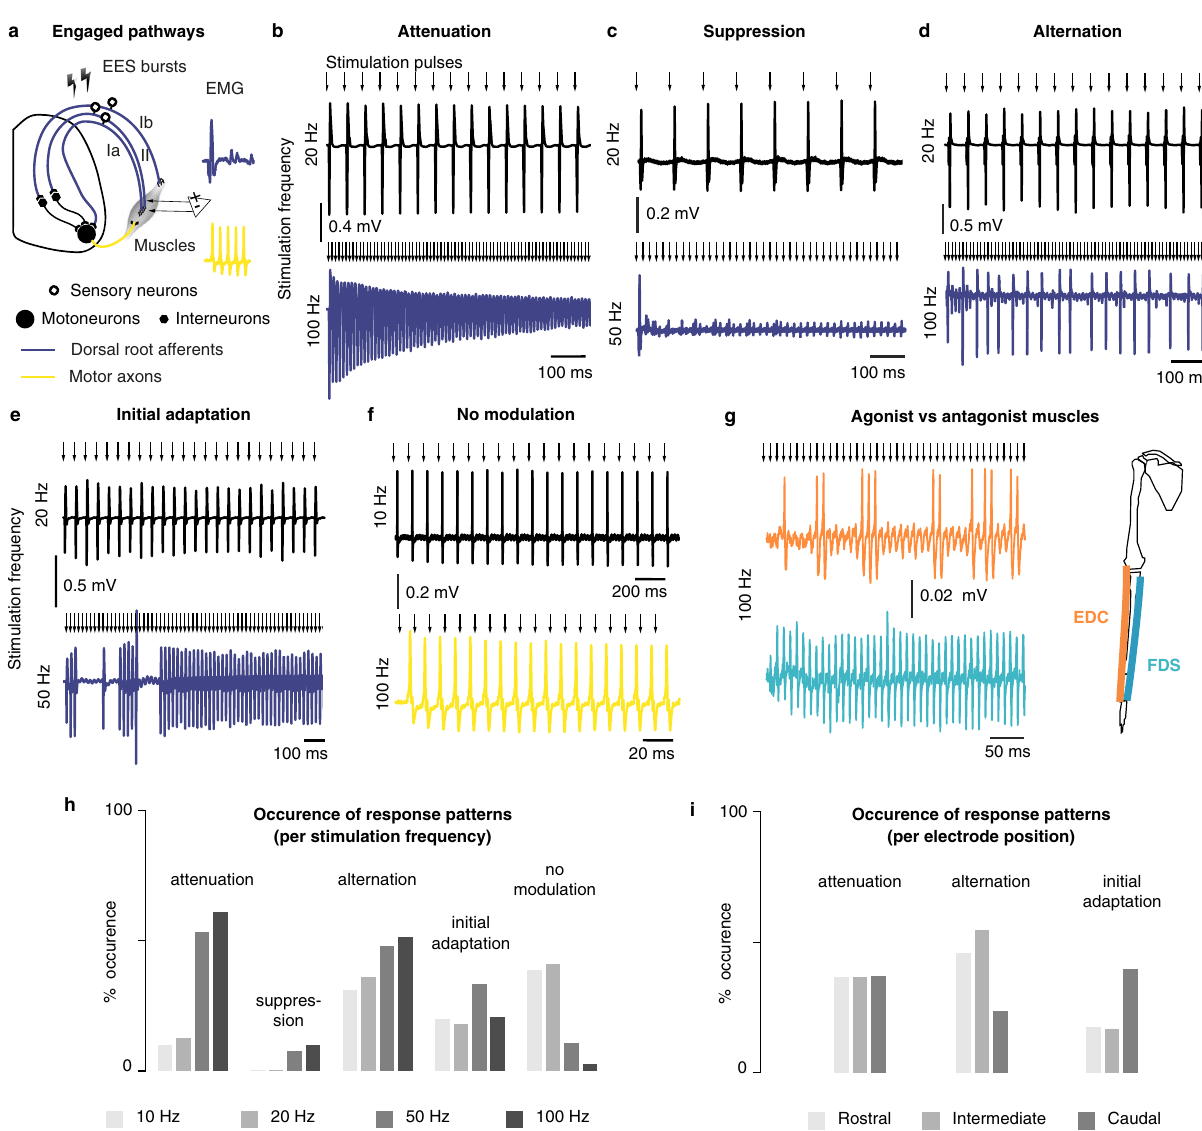
Fig. 7 Patterns of muscular responses elicited during high-frequency stimulation of the cervical spinal cord of monkeys. a Diagram of the presumed engaged pathways during high-frequency stimulation when muscular responses are modulated and unmodulated, respectively. b – e Examples of frequency- dependent modulation of muscular responses. In each panel, the top and bottom EMG traces were recorded in the same muscle and using the same stimulation amplitude (near motor threshold) but different frequencies. f Example of absence of frequency-dependent modulation. g Example of absence of correlation of frequency-dependent modulation between antagonist muscles (the top and bottom traces are simultaneous recordings of the extensor digitorum communis (EDC) and fl exor digitorum super fi cialis (FDS) muscles of Mk-Lo during the same stimulation pulse train). h Frequency of occurrence of modulation patterns with respect to stimulation frequency. All the patterns recorded in all the muscles of the 4 animals in which high-frequency stimulation was tested were included in the analysis ( n = 80 patterns at 10 Hz, n = 39 patterns at 20 Hz, n = 75 patterns at 50 Hz, n = 72 patterns at 100 Hz). i Same as ( h ), but with respect to electrode position ( n = 132 patterns for rostral electrodes, n = 66 patterns for intermediate electrodes, and n = 68 patterns for caudal